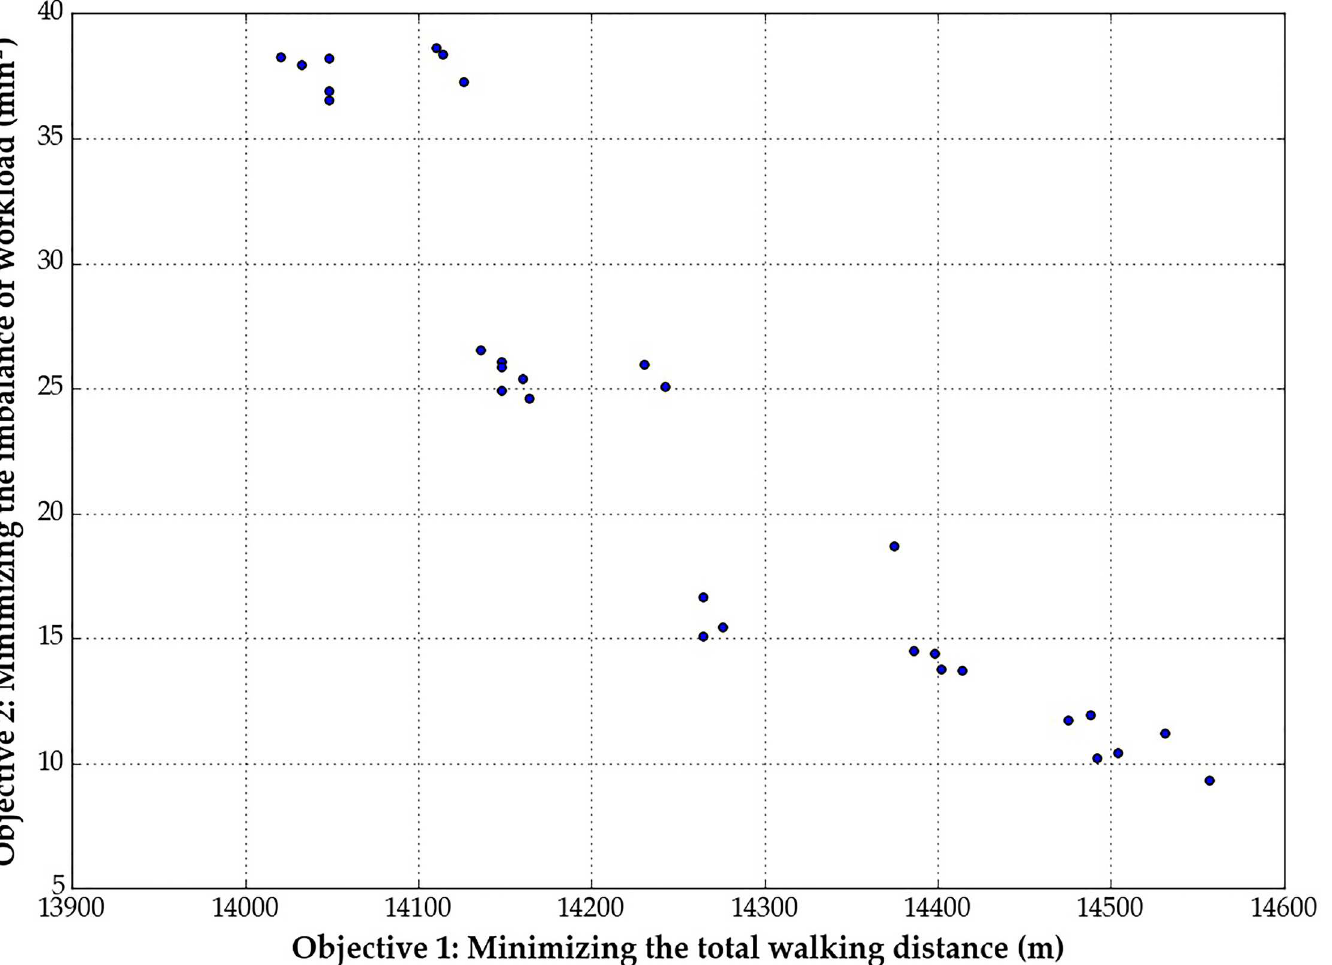
Fig 6. Pareto points without the Pareto